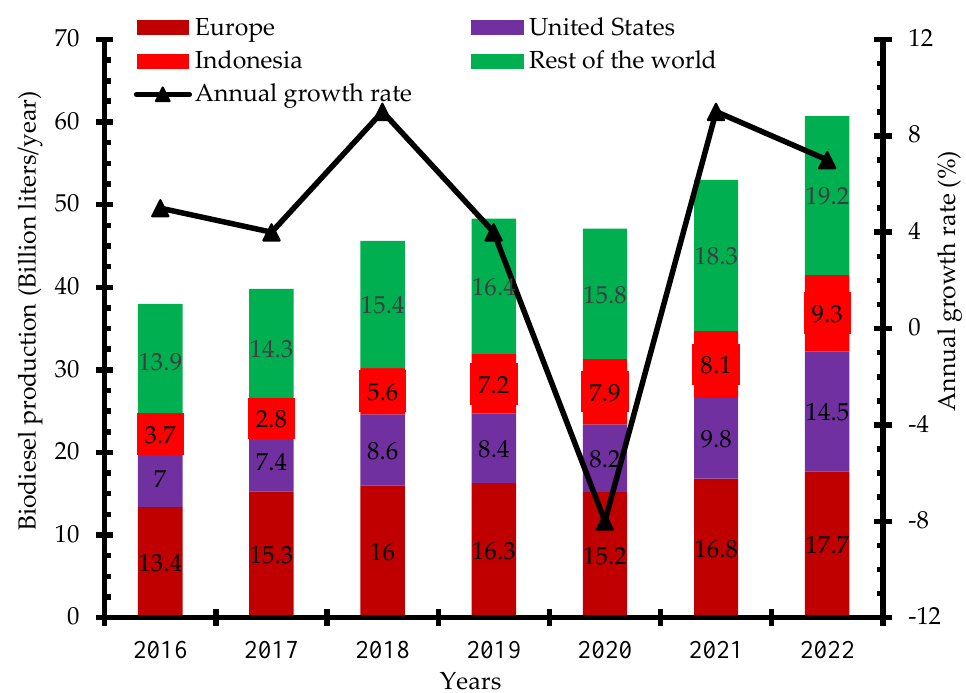
Figure 3. Global biodiesel production 2016–2022 (billion liters/year).